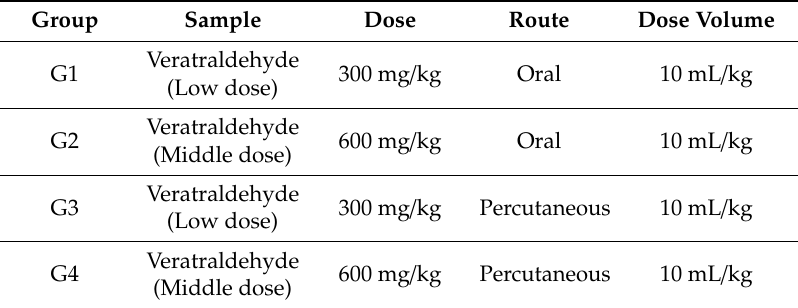
Table 6. Experimental design of pharmacokinetic